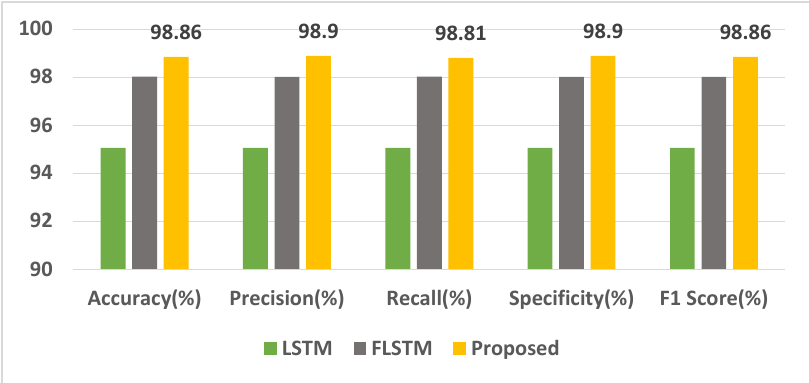
Figure 10. Overall performance results of the proposed model.